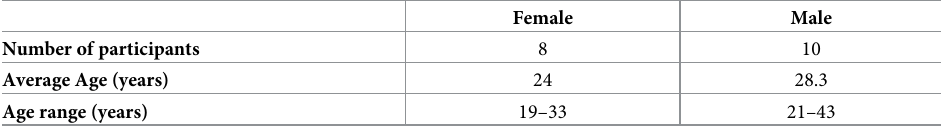
Table 1. Participant